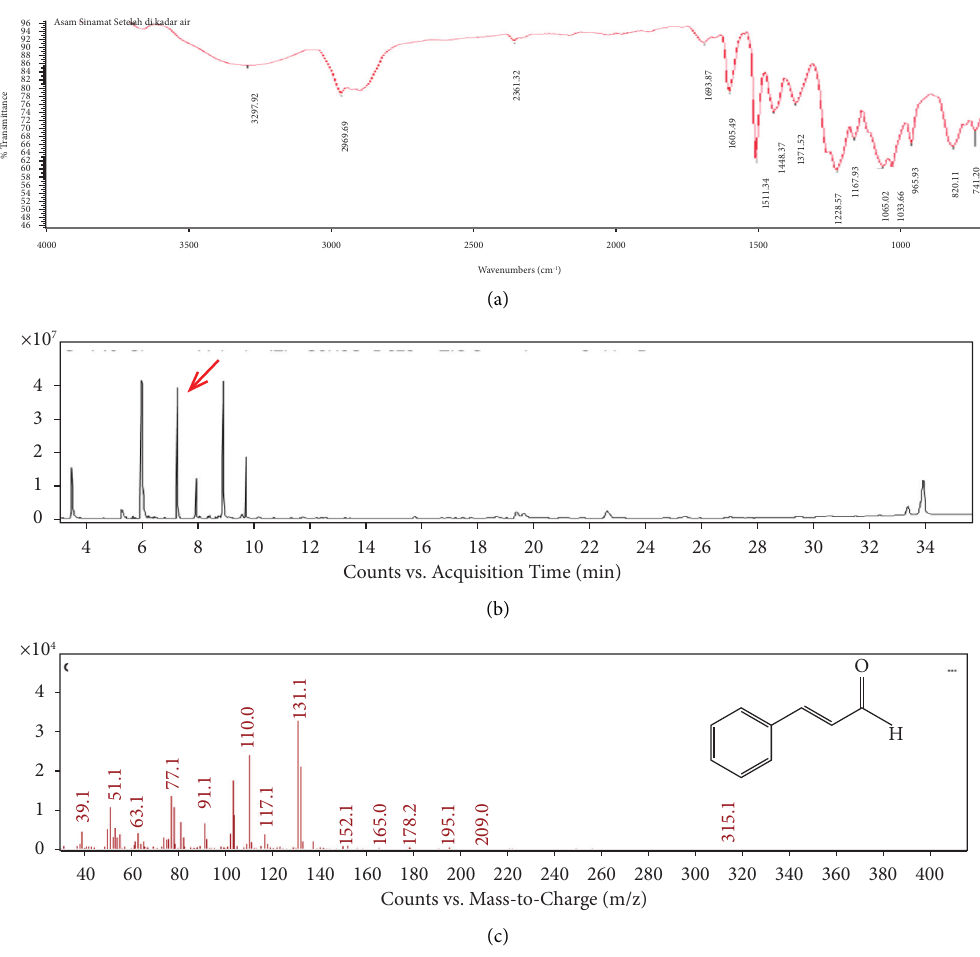
Figure 2: Analysis and characterization of cinnamic acid in the sample: (a) FT-IR spectra, (b) chromatogram GC, with cinnamic acid indicated by the arrow at RT 7.82 minutes, and (c) MS spectra. Table 3: Quantity of frankincense sap produced and composition of cinnamic acid in the sap of selected Styrax benzoin trees. No. Identity of